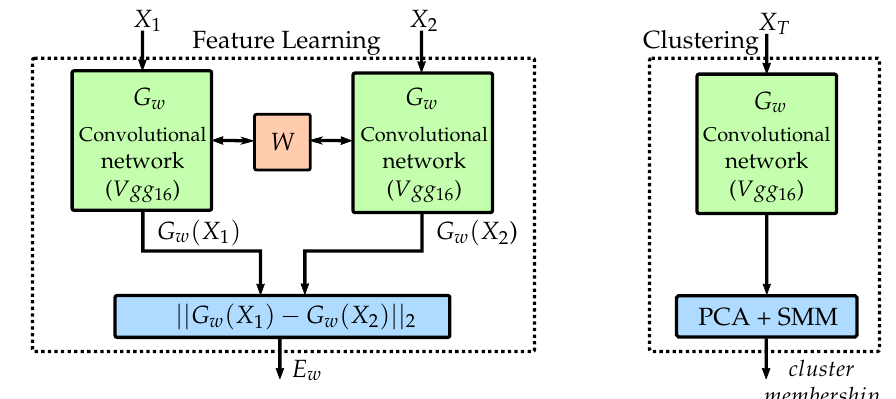
Figure 3. Supervised feature learning and unsupervised clustering, adopted from